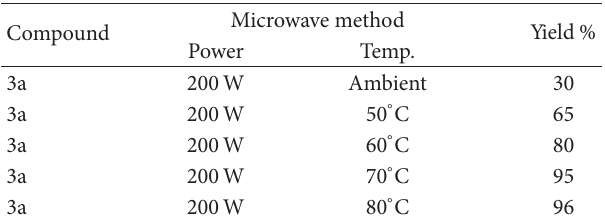
T 1: Comparison of yield of Schiff base (3a) at different temperatures under microwave